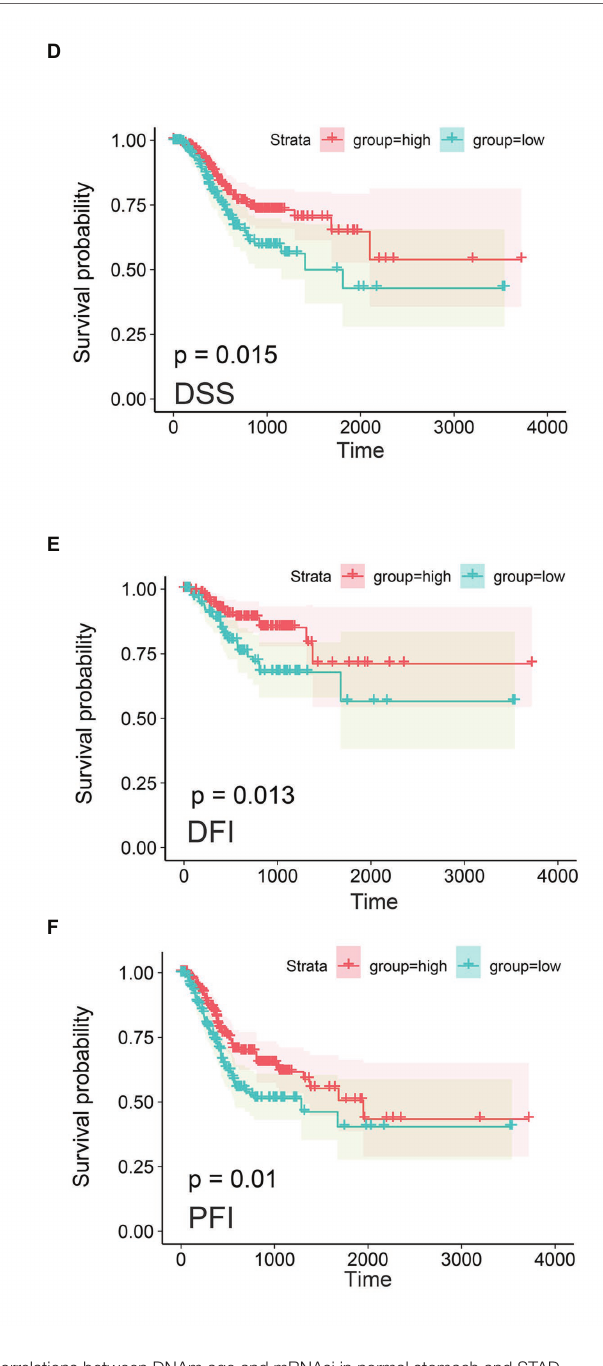
FIGURE 8 | Epigenetic age and tumor stemness features in STAD patients. (A) Correlations between DNAm age and mRNAsi in normal stomach and STAD samples. (B) DNAm age-accelerated group showed higher mRNAsi than DNAm age decelerated group. Two-tailed statistical p values were calculated by two independent samples t-test . mRNAsi was related to the prognosis of STAD patients including OS (C) , DSS (D) , DFI (E) , and PFI (F) . ACC, DNAm age accelerated group; DEC, DNAm age decelerated group; OS, overall survival; DSS, disease specific survival; PFI, progression free interval event; DFI, disease free interval event; STAD, stomach